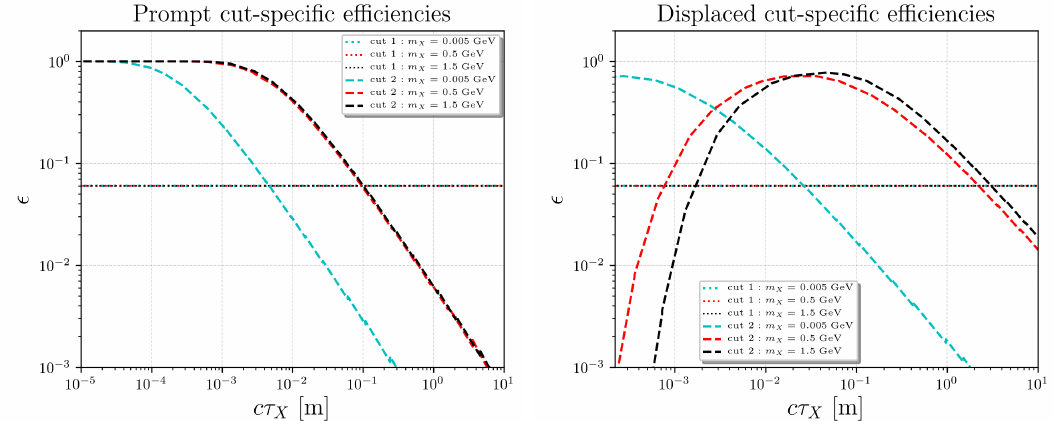
Figure 6 . Efficiencies vs. cτ X for the signal events of Scenario 1, with three benchmark values of m X : 0.005, 0.5, 1.5 GeV. Left : prompt cut-specific efficiencies. Right : displaced cut-specific efficiencies. “Cut 1” denotes the baseline efficiency. For the prompt search, “cut 2” is the efficiency of requiring d 0 < 5 mm, z 0 < 30 mm, and r < 10 cm. For the displaced search, “cut 2” gives the efficiency of applying the fiducial-volume and the displaced-tracking